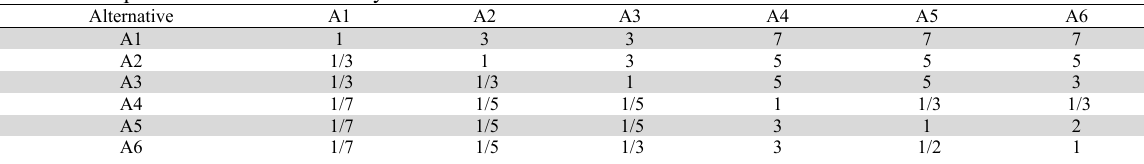
Pairwise comparison matrix of